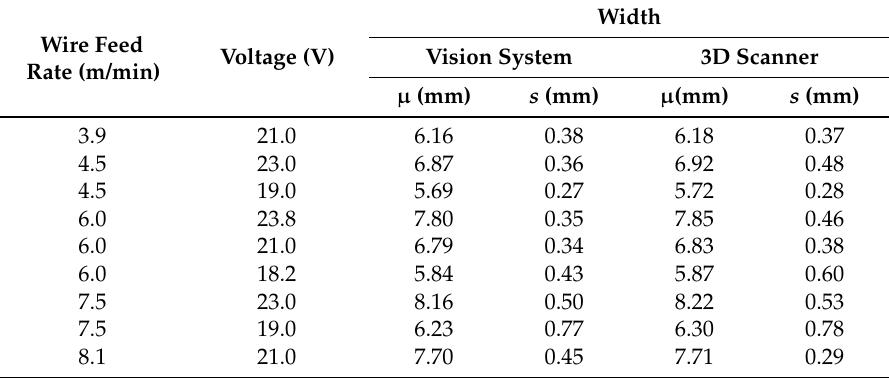
Table 1. Measurement results of width.